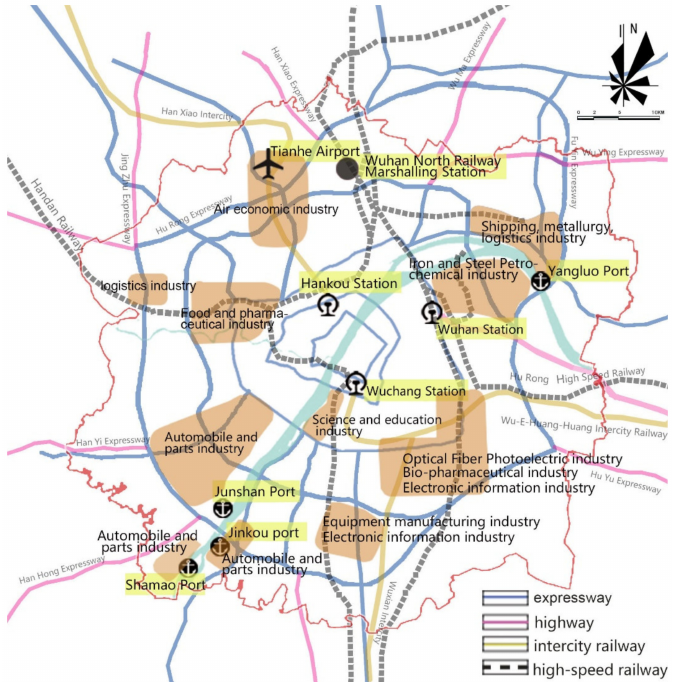
Figure 8. Distribution of important traffic facilities and manufacturing agglomerations in the Wuhan metropolitan